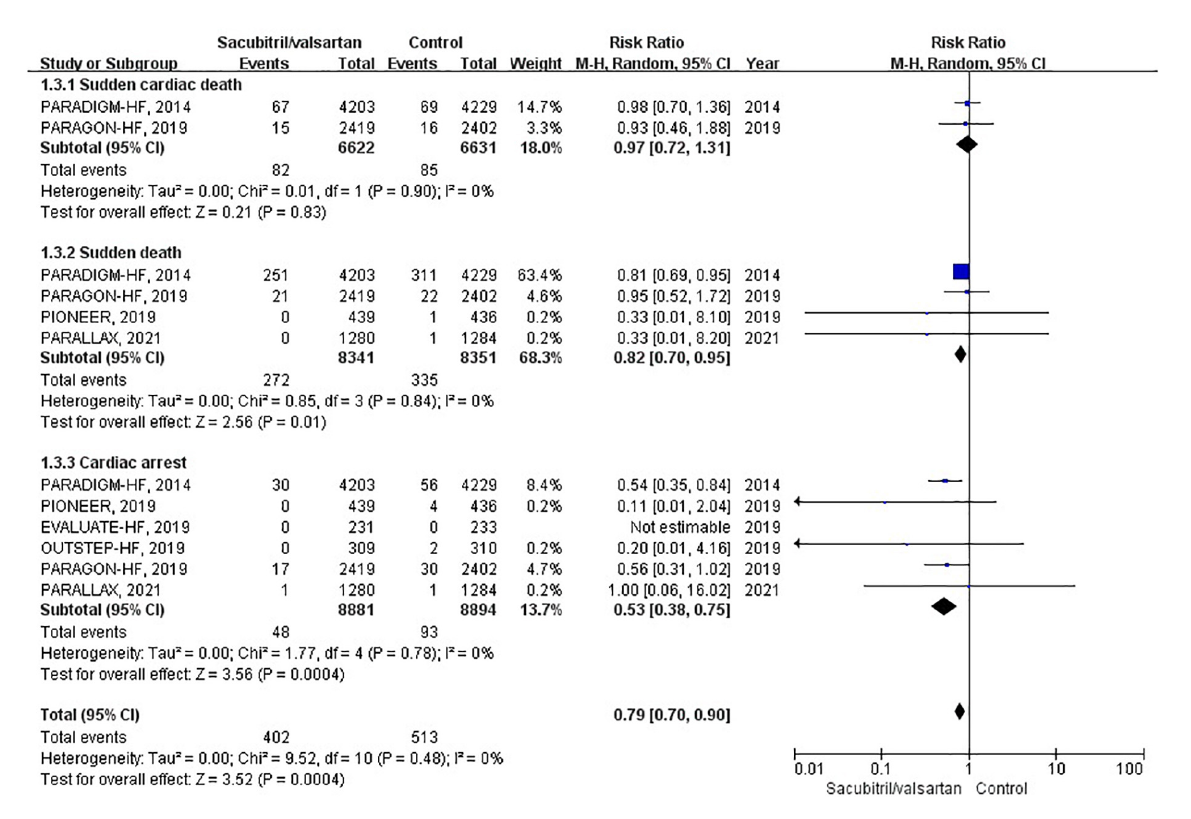
FIGURE5 Forest plot comparing the risk of sudden cardiac death between sacubitril/valsartan and